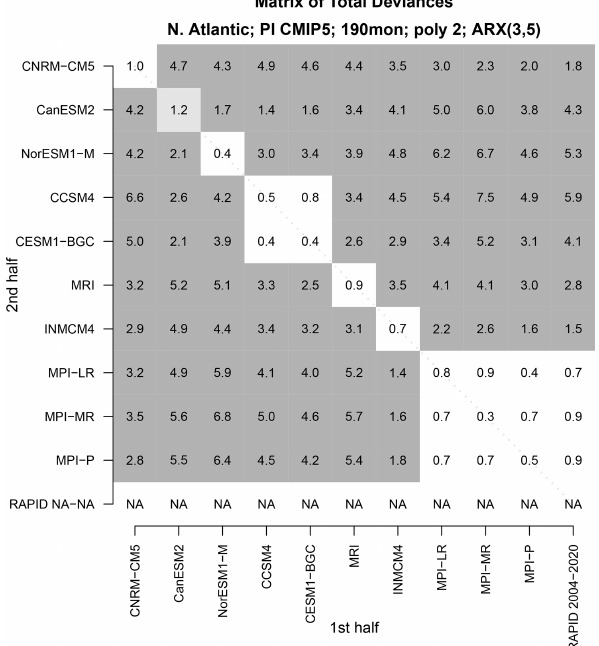
Figure 7. The total deviance between the time series shown in Fig. 2, and an independent “second-half” time series from CMIP5 models. The deviance is normalized by the 5% significance value. Values that are insignificant, 5% significant, and 1% significant are indicated by no shading, light grey shading, and dark grey shading, respectively. There is no “second-half” time series for observations, but an associated bottom row is included to make the matrix square.